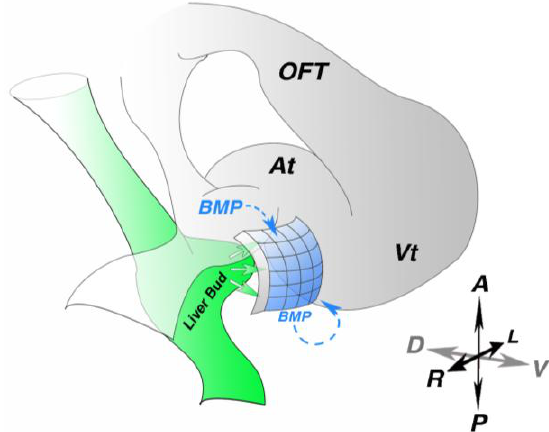
Figure 2. Proepicardial molecular induction. ( A ) Diagram of an early looping stage heart. Liver bud (green)-derived signals induce proepicardial marker expression in the adjacent mesothelium (blue). Paracrine and autocrine bone morphogenetic protein (BMP) signaling is also critical for proepicardial marker gene expression. At (cid:178) atria; OFT (cid:178) out flow tract; Vt (cid:178) ventricle; A (cid:178) anterior; P (cid:178) Posterior; R (cid:178) right; L (cid:178) left; D (cid:178) dorsal; V (cid:178)